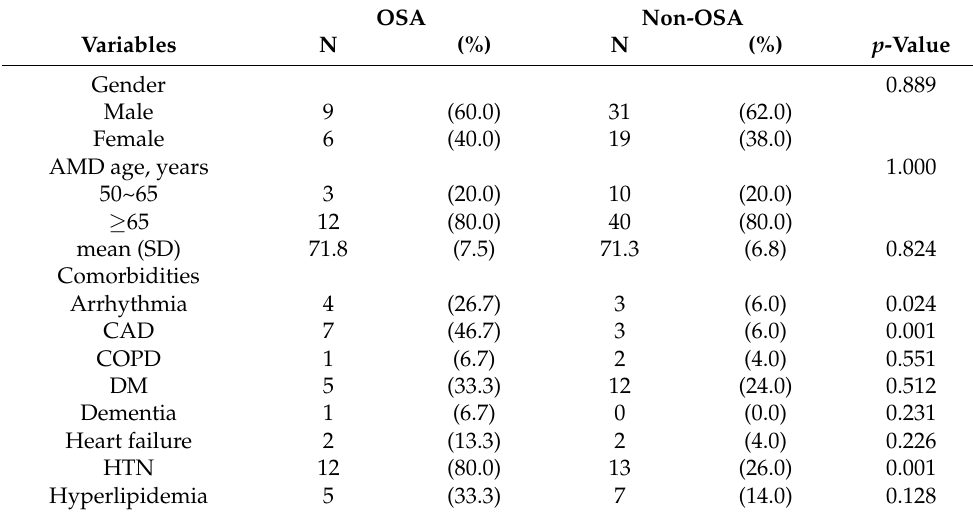
Table 1. Baseline characteristics of study